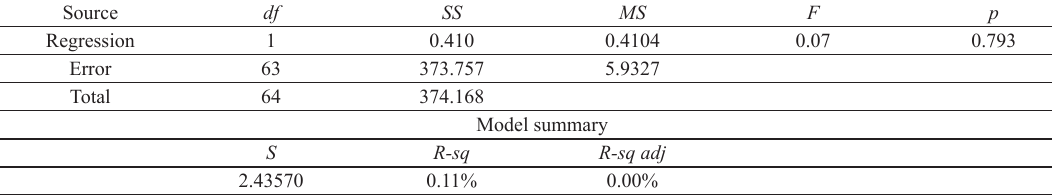
Table 8. Analysis of Variance: Radial Tension Strength versus Density.